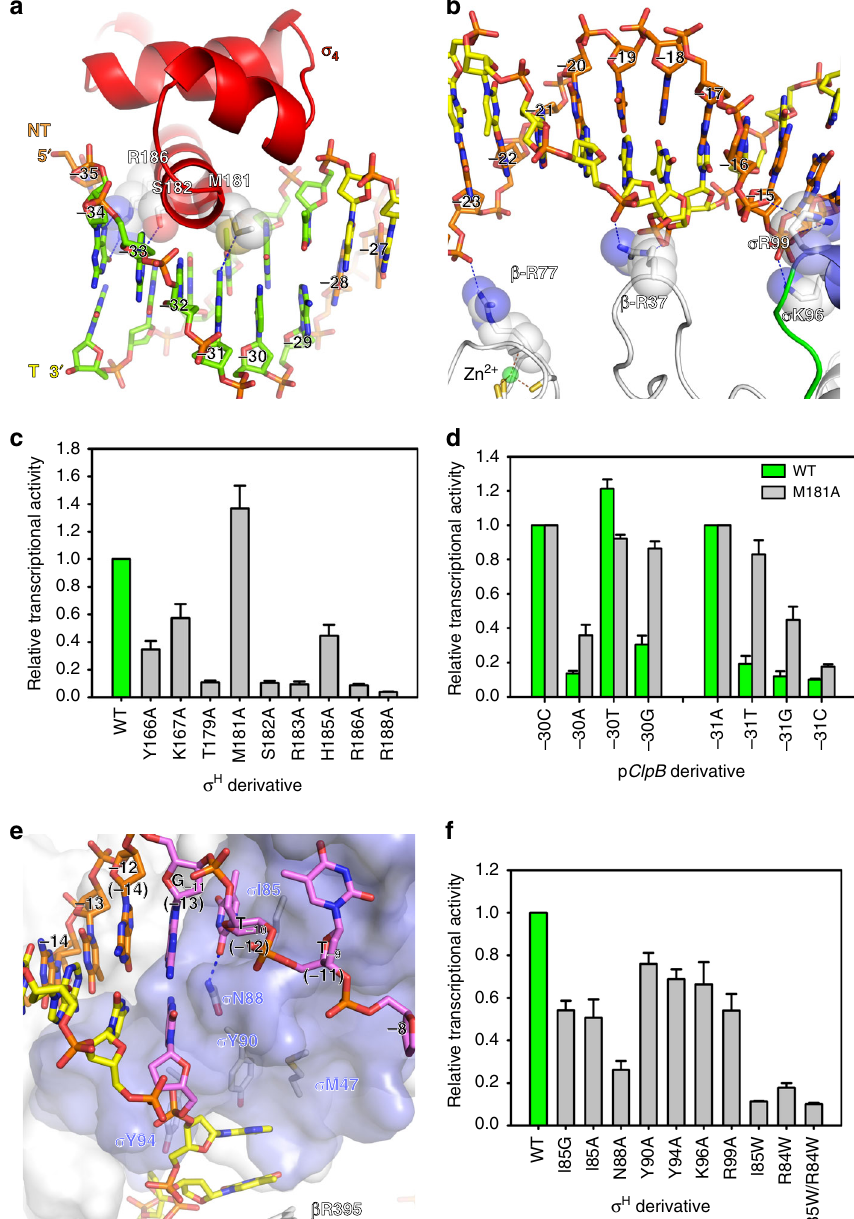
Fig. 4 The interaction between upstream promoter DNA and RNAP in the Mtb σ H -RPo structure. a The interaction between σ H 4 and the − 35 element. σ H 4 , red ribbon. The residues making base-speci fi c interactions are presented as ribbon and half-transparent spheres; the C, O, N, and S atoms of the residues are colored in white, red, blue, and yellow respectively. The C, O, N, and P atoms of the − 35 DNA are colored in green, red, blue, and orange, respectively. H-bond, blue dash. b The interaction between RNAP and − 35/ − 10 spacer region of upstream dsDNA. The residues making polar interactions with DNA are shown and colored as above. The C atoms of the − 35/ − 10 spacer DNA are colored in yellow (template DNA) or orange (nontemplate DNA), and the rest of atoms are colored as above. c The in vitro transcription activity of σ H derivatives comprising alanine substitution on σ H 4 . d M181A changes the sequence speci fi city for positions − 30 and − 31 of the − 35 element. e The promoter melting by σ H . The numbers in parenthesis correspond to positions in σ A -RPo − 10 element is colored in purple. The residues involved in promoter melting are shown in stick and colored in white (C atoms), red (O atoms), . The and blue (N atoms). f The in vitro transcription activity of σ H 2 derivatives with alanine or tryptophan substitutions. The experiments were repeated in triplicate, and the data are presented as mean ± S.E.M. Source data of c , d , and f are provided as a Source Data fi